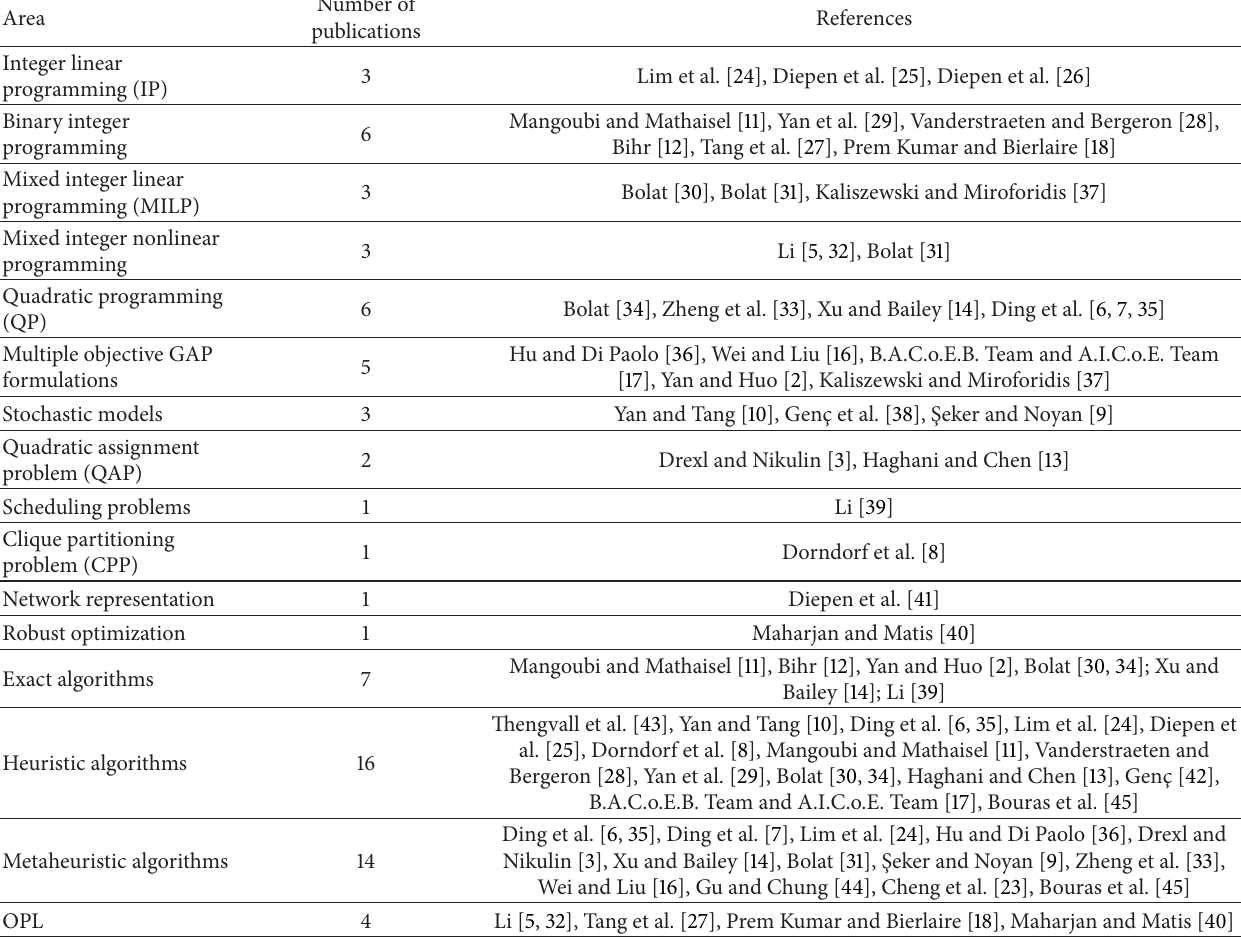
Table 4: Number of publications per research area.